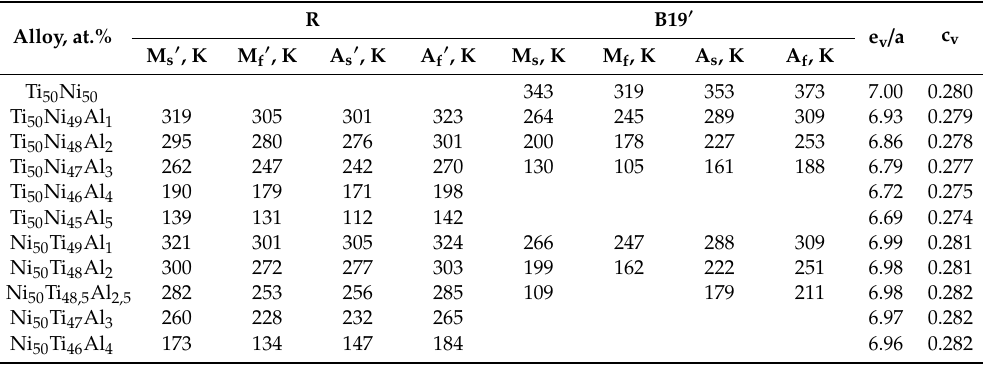
/ a and their concentration c v v .